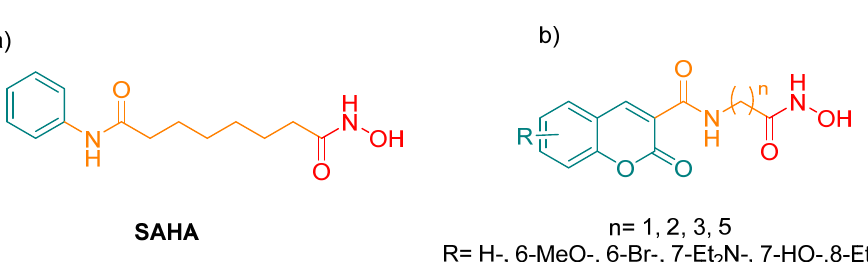
Figure 3. Fluorescent probes for the detection of HDAC activity. ( a ) Coumarin structure for real-time detection of HDAC activity, ( b ) K4(Ac)-CCB structure for monitoring of HDAC activity, ( c ) Scriptaid derivative ( d ) Coumarin probe that can access the catalytic site of HDAC, ( e ) Coumarin-SAHA derivatives.